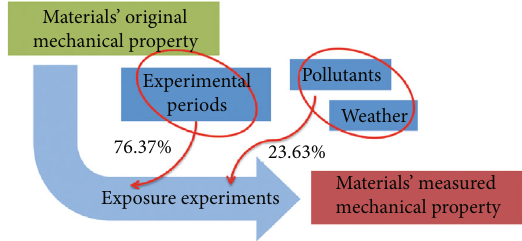
Figure 5: Relationship schema between the various factors in fl uencing the tensile property degradation.